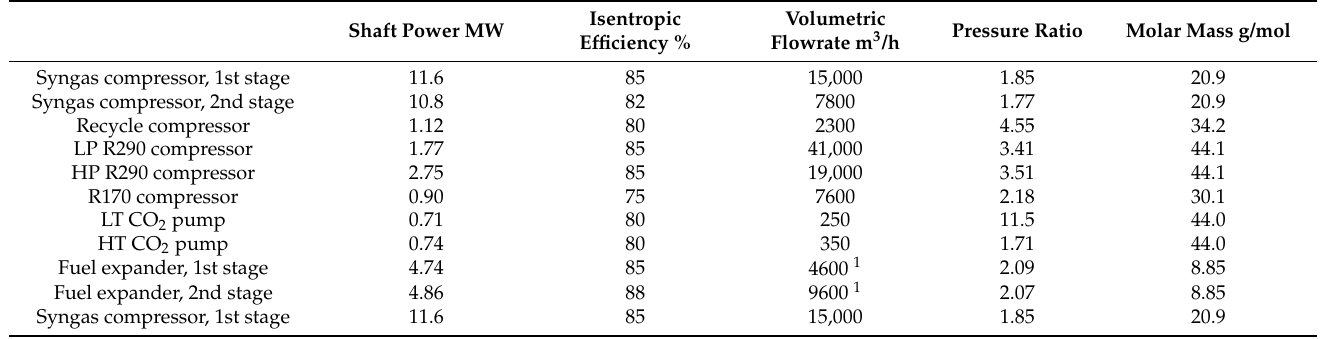
Table 3. Summary of rotating equipment in the low-temperature capture